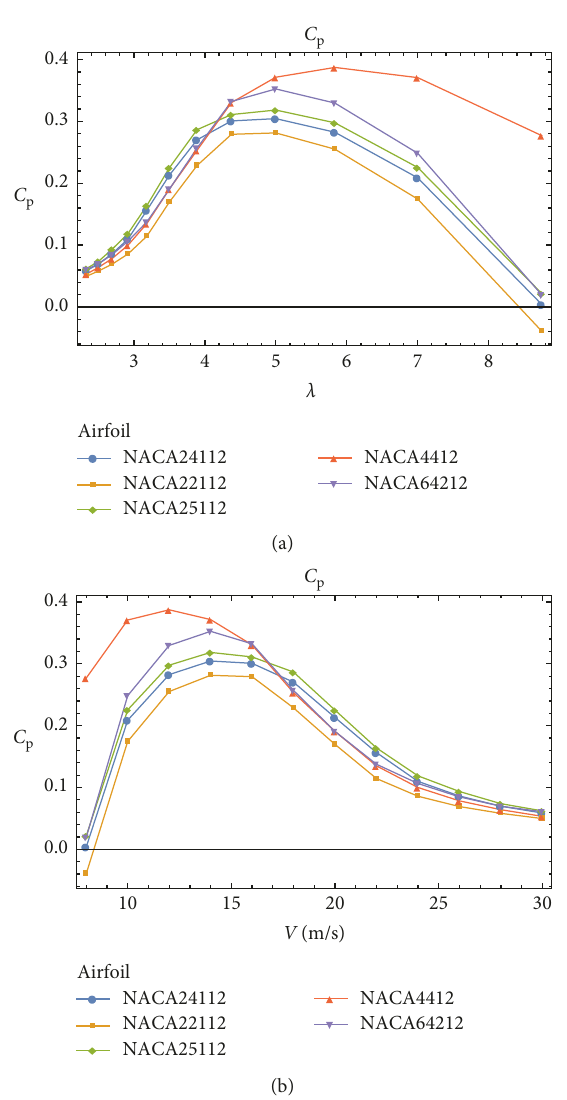
Figure 7: Evaluation of power coefficient ( C and wind